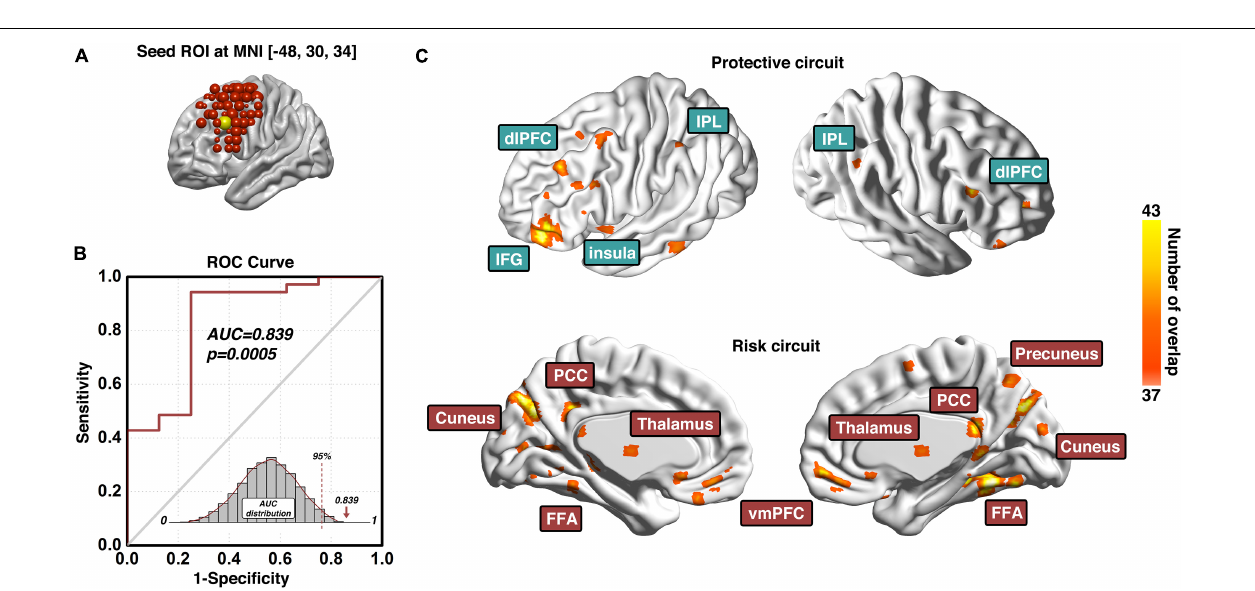
FIGURE 2 | Clinical characterization of cocaine relapse. The Kaplan–Meier curve illustrates the survivorship of participants in terms of maintaining abstinence.